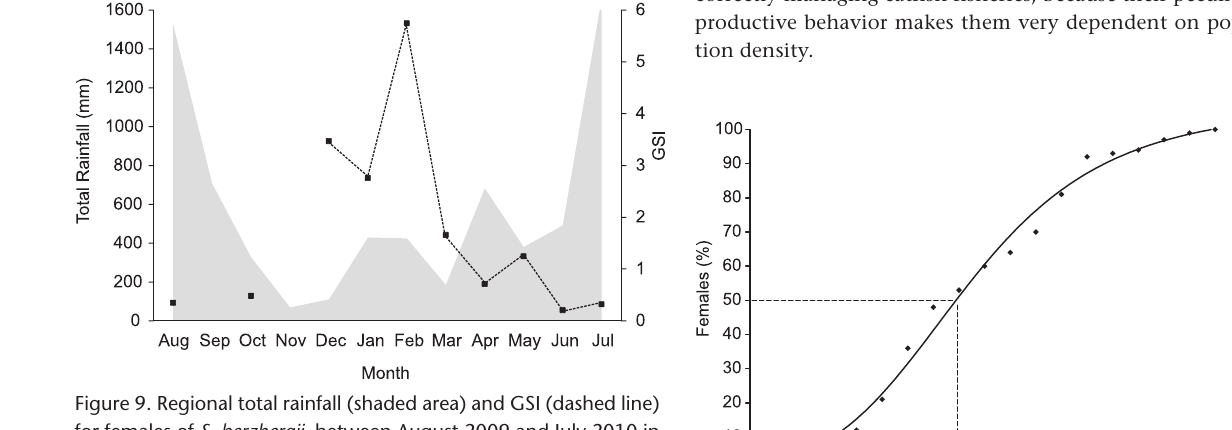
) for S. herzbergii 50